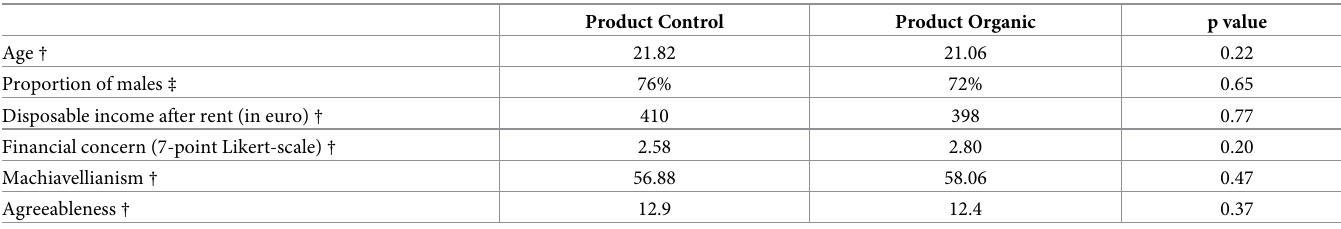
Table 1. Comparison of subjects in product control and product